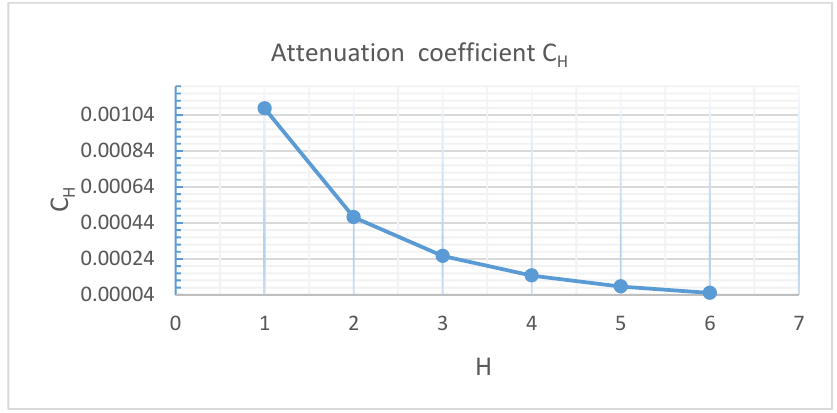
Figure 3. Attenuation coefficient evolution C H versus pole pair number H.